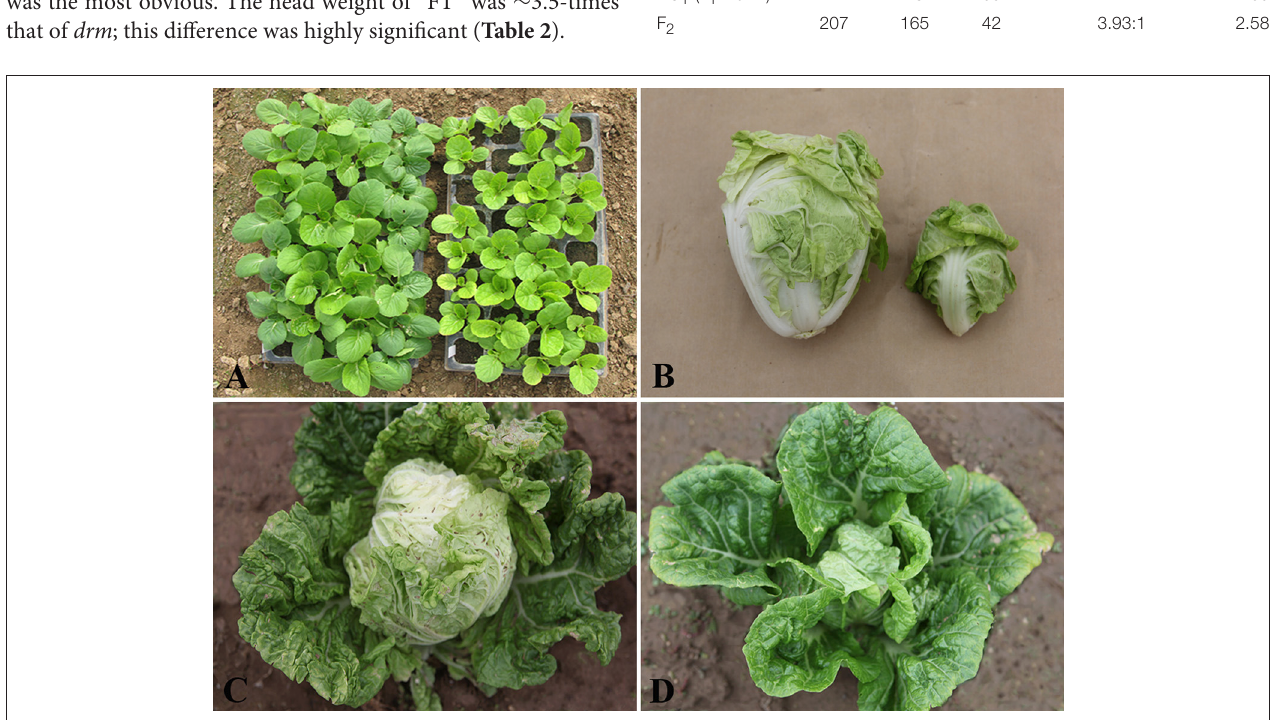
FIGURE 1 | Phenotypic characterization of drm and wild-type “FT.” (A) “FT” (left) and drm (right) at the seedling stage; (B) leafy head of “FT” (left) and drm (right); (C) “FT” at the heading stage; (D) drm at the heading stage.